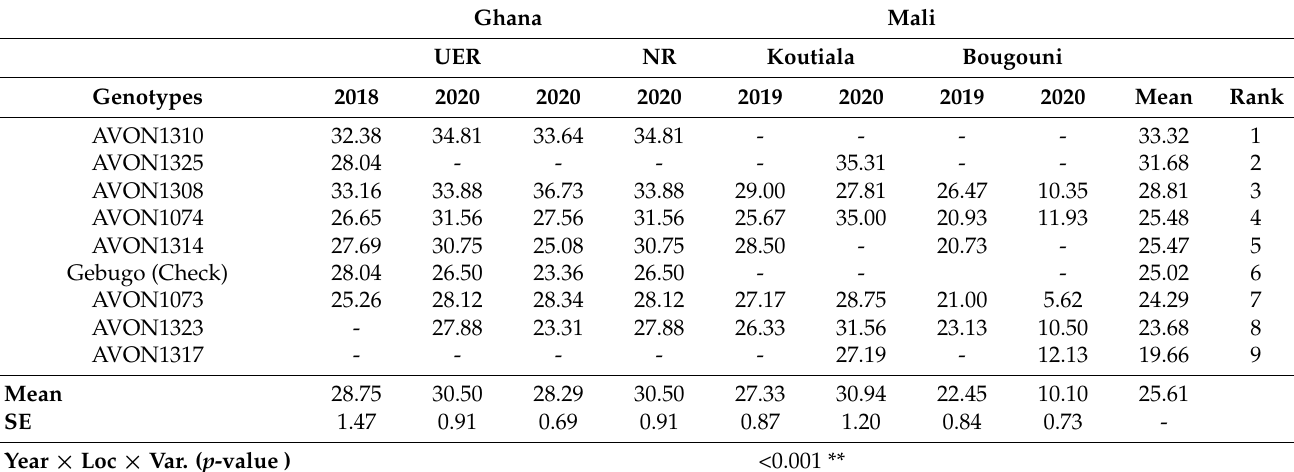
Table 3. G × E interaction (AMMI) for yield performance (t.ha − 1 ) of onion varieties over years and locations in Ghana and